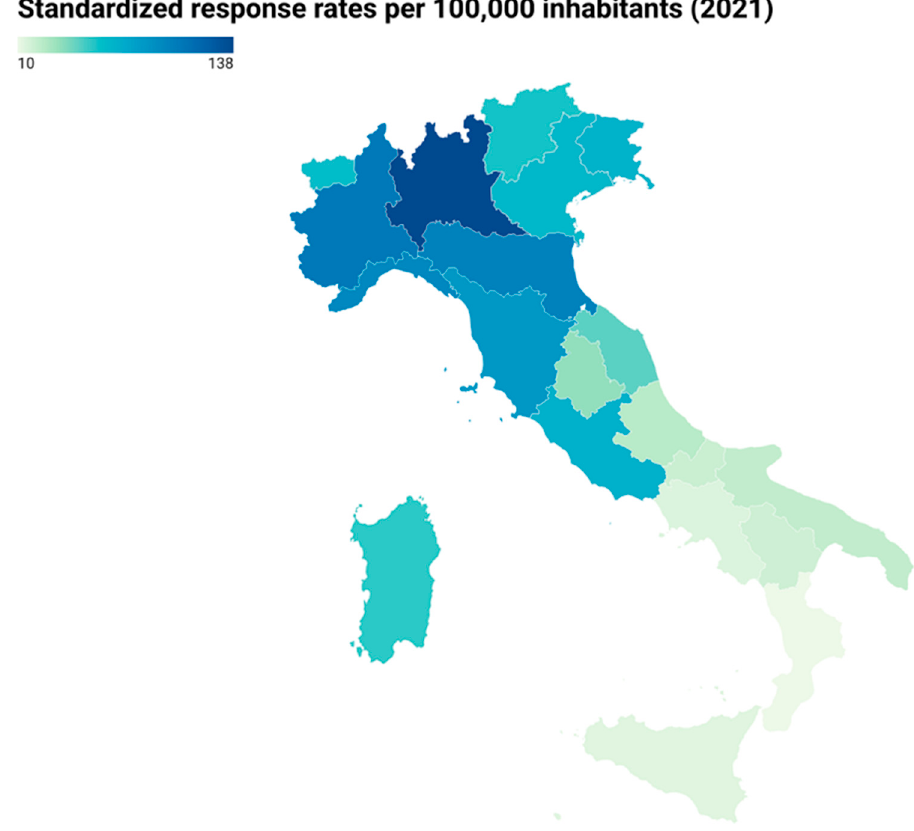
Figure 2. Response rates by Italian region in the phase II survey. Darker coloured regions indicate higher response rates.